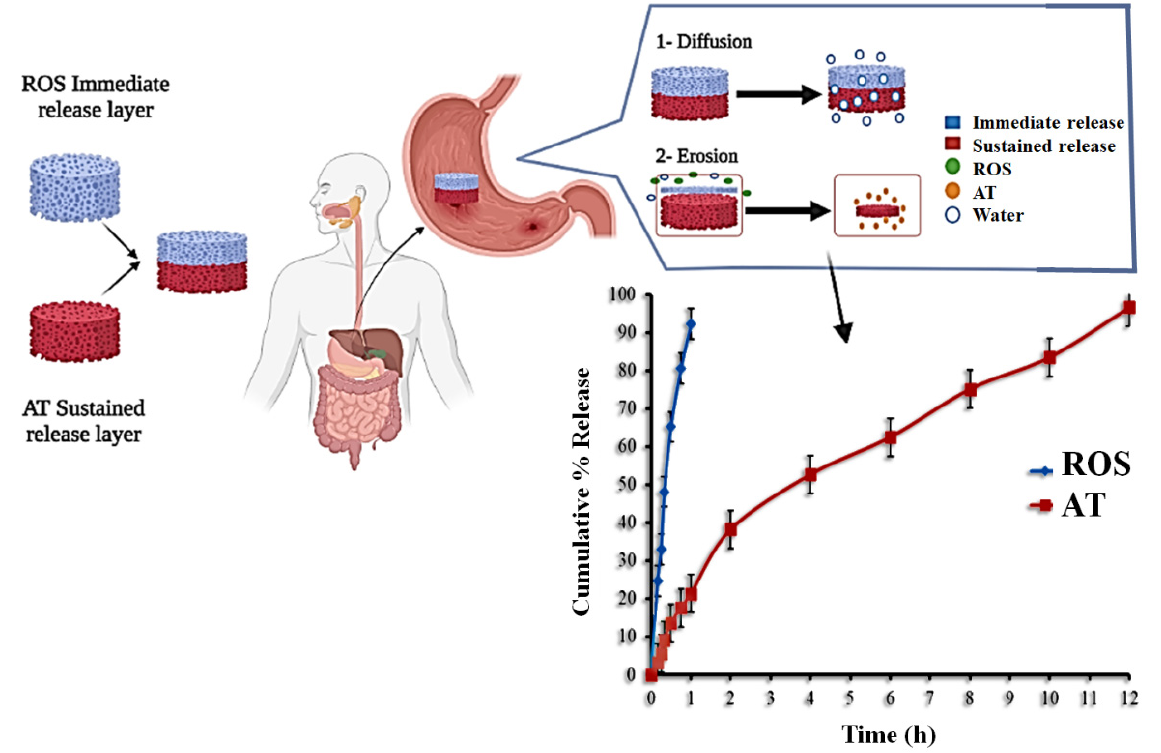
Figure 1. Schematic diagram of ROS/AT bilayer floating tablet design experiment.